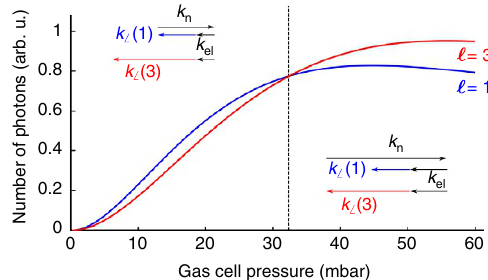
Figure 5 | Calculated yield within the modes. The yield is calculated for the c ¼ 1 (blue) and c ¼ 3 (red) modes as a function of gas pressure (see Methods). The crossing of the two curves is indicated by the vertical dashed line. On the left (right) of this line, the phase matching favours the c ¼ 1 ( c ¼ 3) mode, as shown in the insets. k n and k el , are, respectively, the contributions of the neutral and free electron dispersion to the phase matching, and are the only terms that depend on the